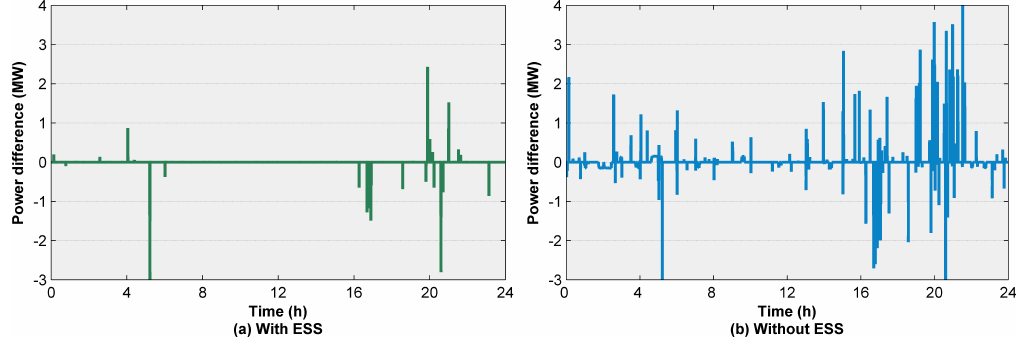
Figure 7. The power difference under the hybrid system ( a ) and the AGC system without energy storage system (ESS) ( b